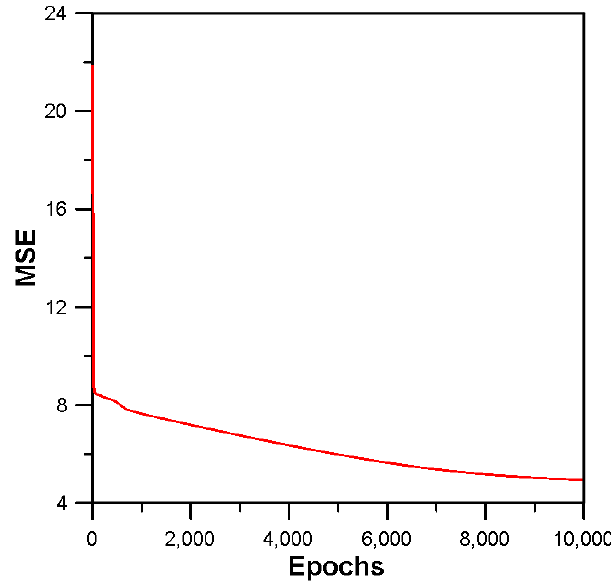
Figure 19. Prediction results according to the epochs when Ftrl+IHS is applied.